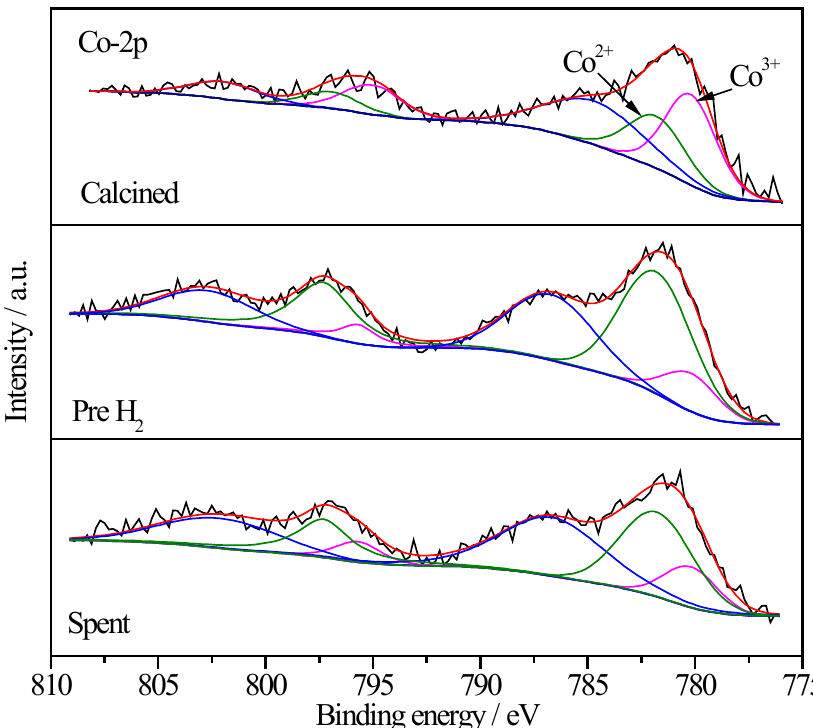
Figure 16. Co-2p XPS spectra of the calcined, reduced, and spent Pt/CoO x /TiO 2 .